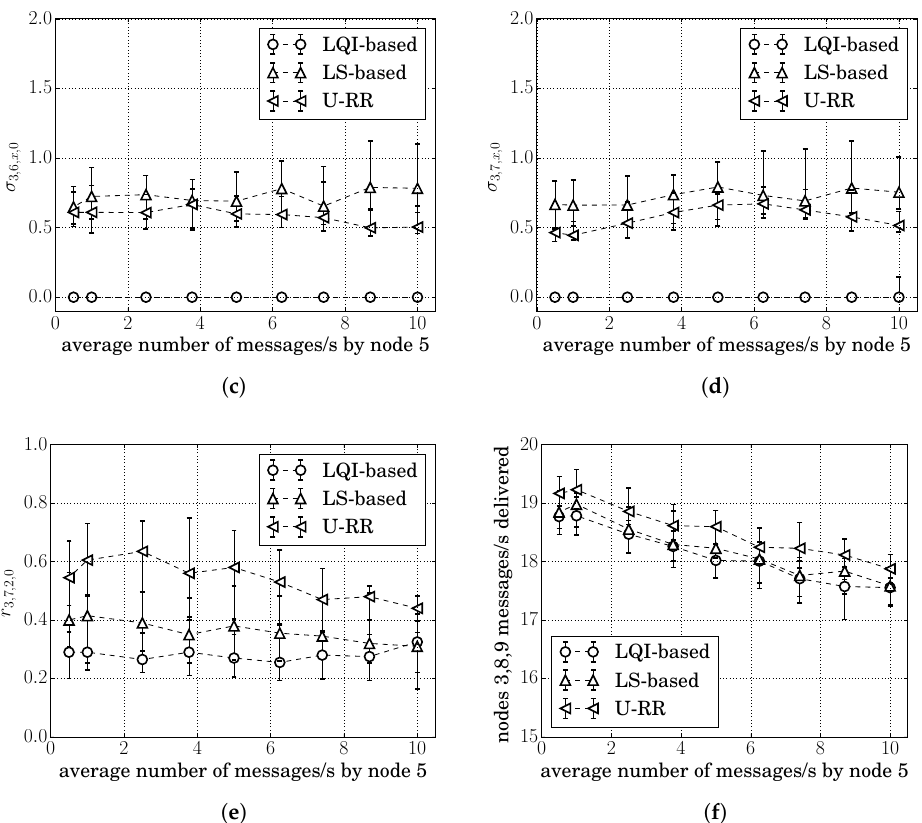
Figure 12. The median and the 15th to 85th percentiles of ( a ): the cumulative route cost of the routes 3,6,x,0 ( c 3,6, x ,0 ), ( b ): the cumulative route cost of the routes 3,7,x,0 ( c 3,7, x ,0 ), ( c ): the standard deviation of the estimated costs measured at node 3 for the routes 3,6,x,0 ( σ 3,6, x ,0 ), ( d ): the standard deviation of the estimated costs measured at node 3 for the routes 3,7,x,0 ( σ 3,7, x ,0 ), ( e ): the ratio of times that packets were relayed by the best routes 3,6,1,0 and 3,7,2,0 ( r 3,6,1,0 + r 3,7,2,0 ), and ( f ): the delivery rate of messages originated at nodes 3, 8, and 9 in the scenario